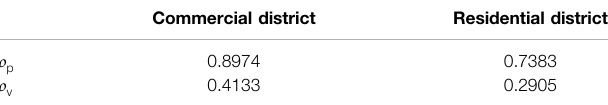
TABLE 3 | Optimization results of time-of-use price. Unit: